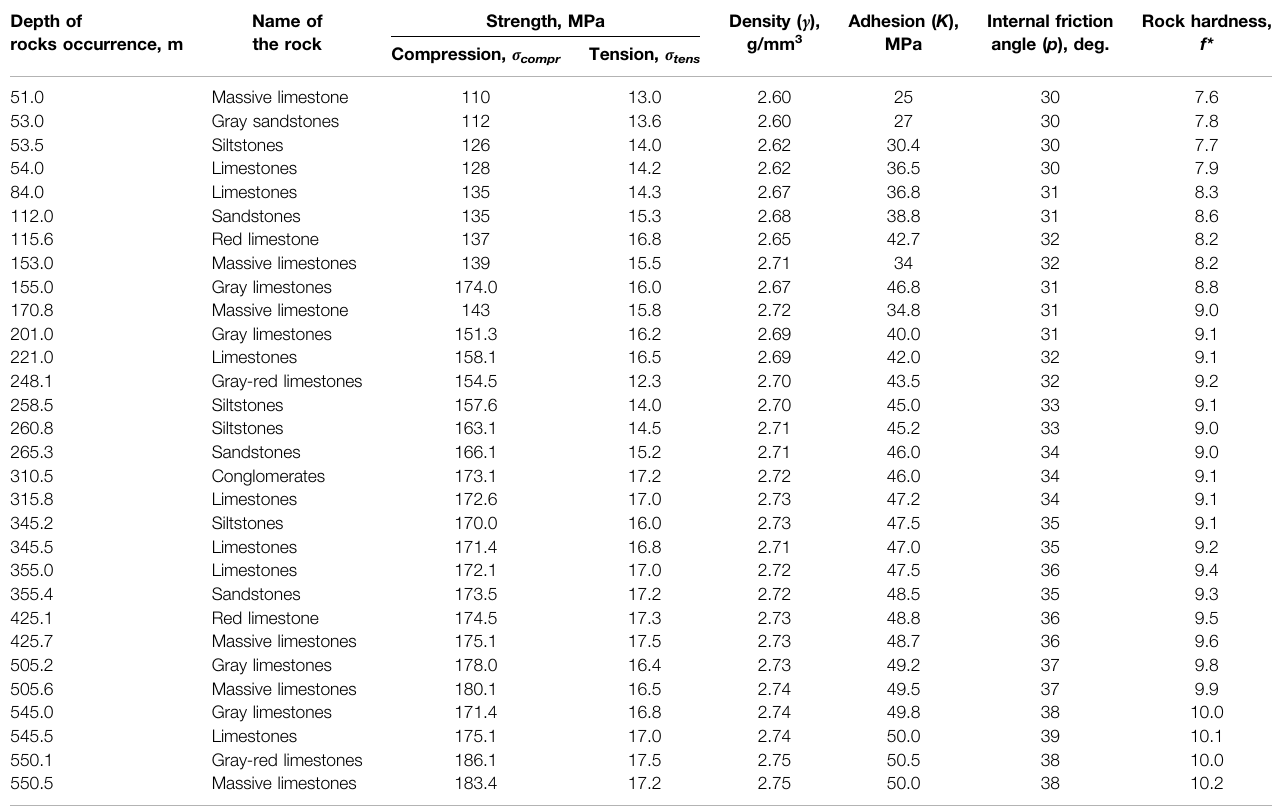
TABLE 1 | Physical-mechanical properties of rocks from the Saryoba deposit. Depth of rocks occurrence, m